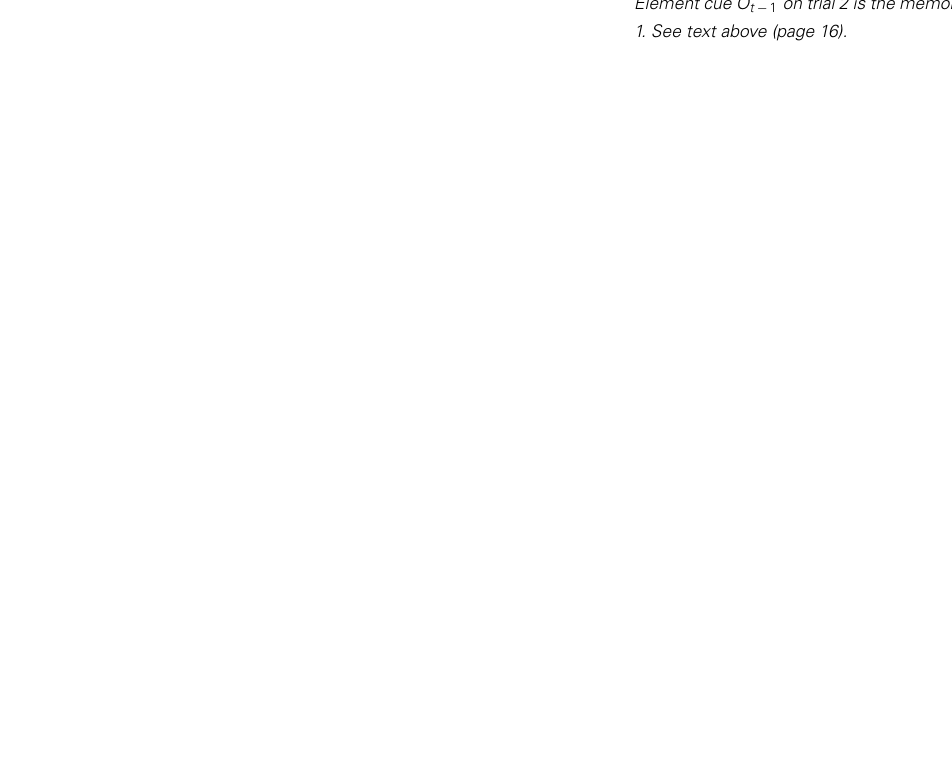
Element cue O t − 1 on trial 2 is the memory of the outcome that occurred on trial 1. See text above (page